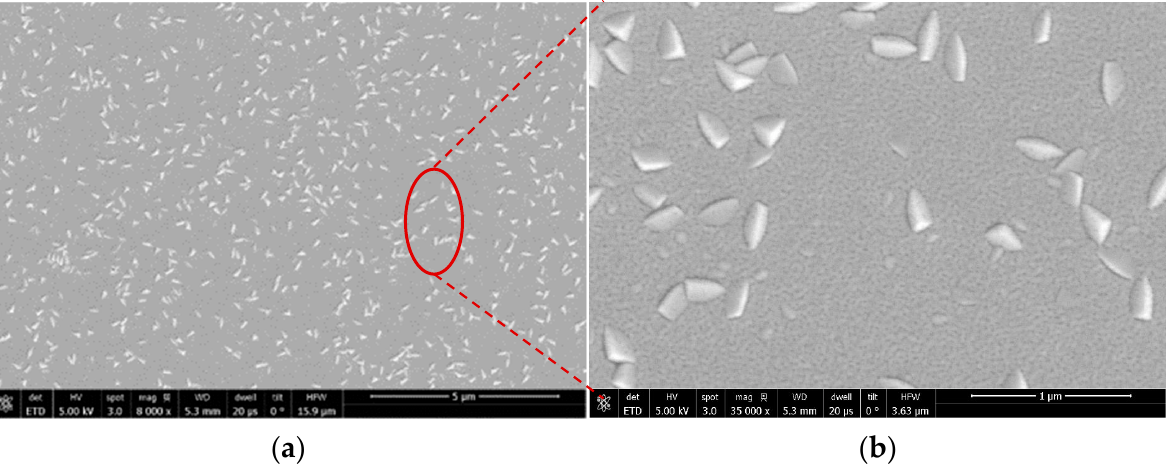
Figure 1. SEM image of the ( a ) Sc 0.40 Al 0.60 N surface with abnormally oriented grains (AOG), ( b ) Direction of the AOGs (in micron scale).